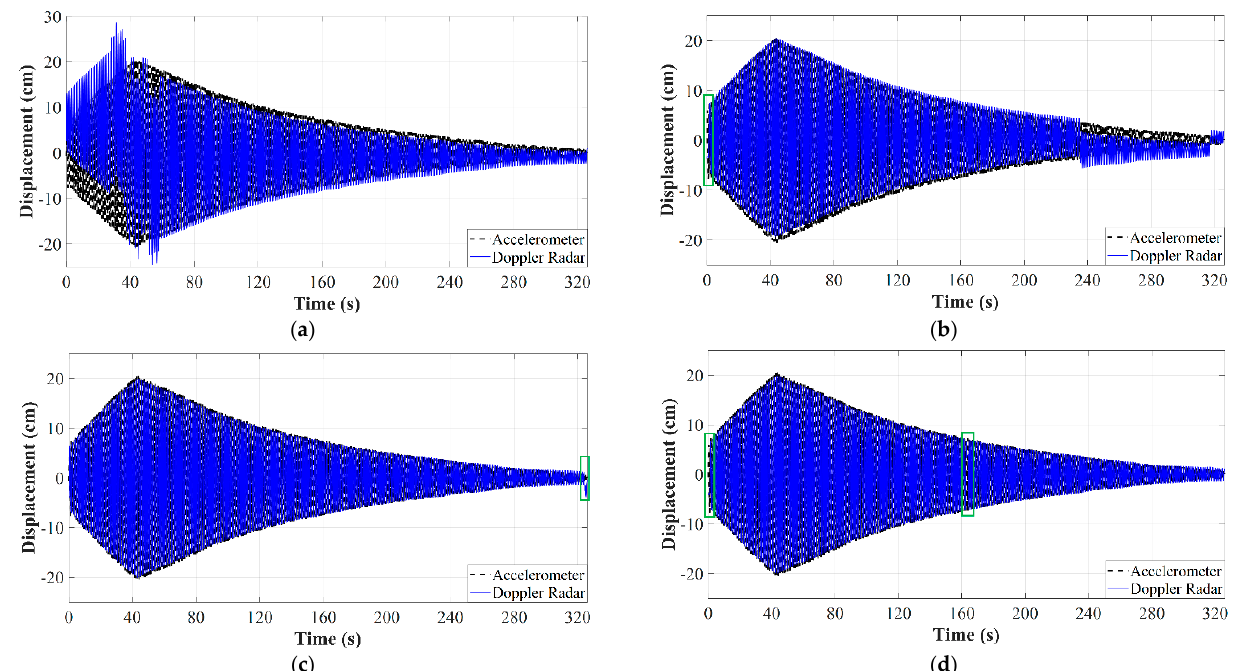
Figure 9. Experimental results: ( a ) demodulated displacement using the non-adaptive JSPA; ( b ) demodulated displacement using the non-adaptive ALFA; ( c ) demodulated displacement using the AJSPA; ( d ) demodulated displacement using the ALFA. Discontinuities are highlighted in ( b – d ). Reprinted with permission from ref. [71]. Copyright 2020 IEEE.